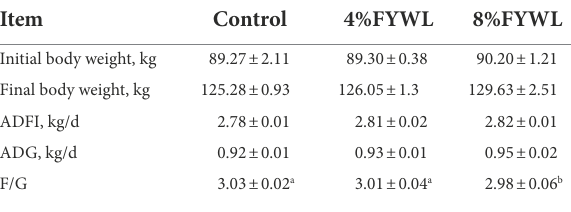
TABLE 3 Effects of supplementation with FYWL (4 and 8%) on the growth performance in finishing